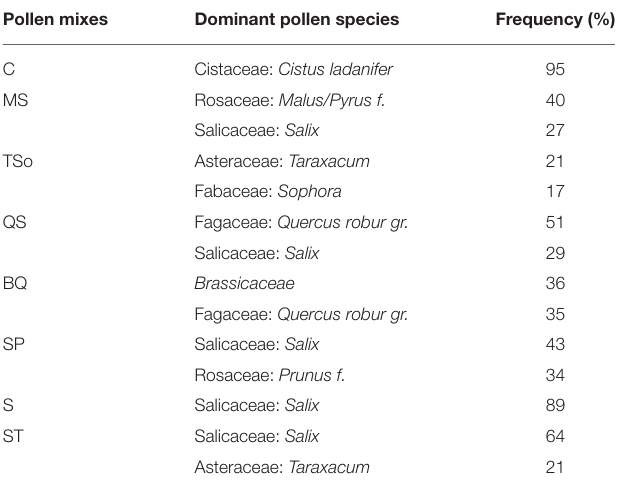
TABLE 1 | Frequency (%) of most represented pollen species in the 8 pollen